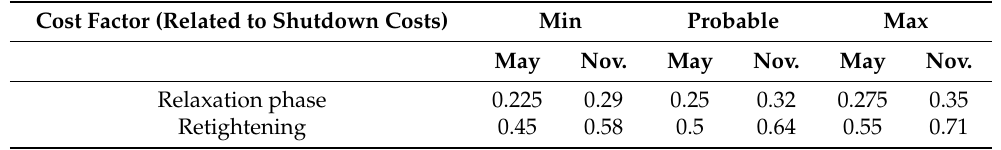
Table A6. Estimated proportional